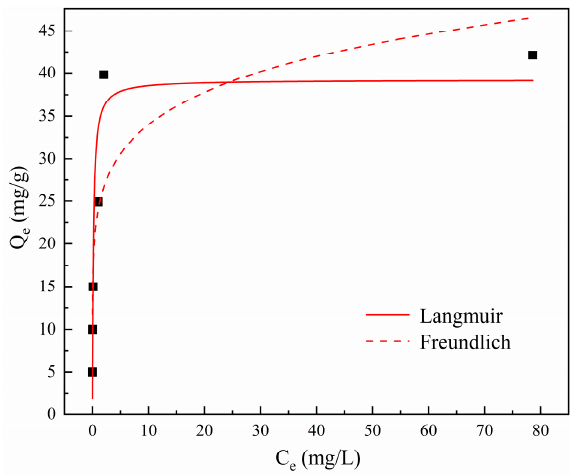
Figure 7. Isotherm models for Cd 2+ removal using tobermorite. Table 2. Isotherm model parameters for Cd 2+ removal using tobermorite.